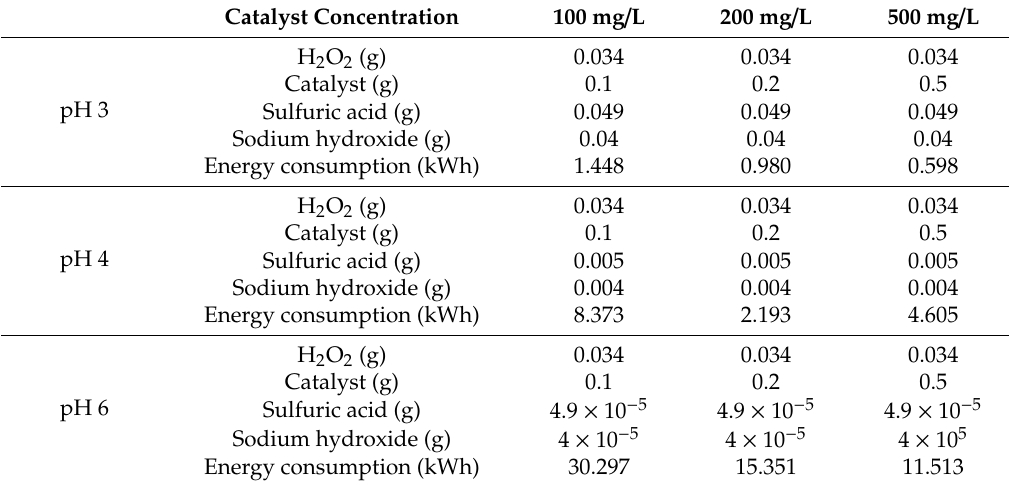
Table 13. Inventory of the input related for the treatment of 1 L of Milli-Q water contaminated with BPA (20 µ M) in the presence of di ff erent Fe 3 O 4 / HA loadings (from 100 to 500 mg / L at pH 3, 4, and 6 in the presence of 1mM of H 2 O 2